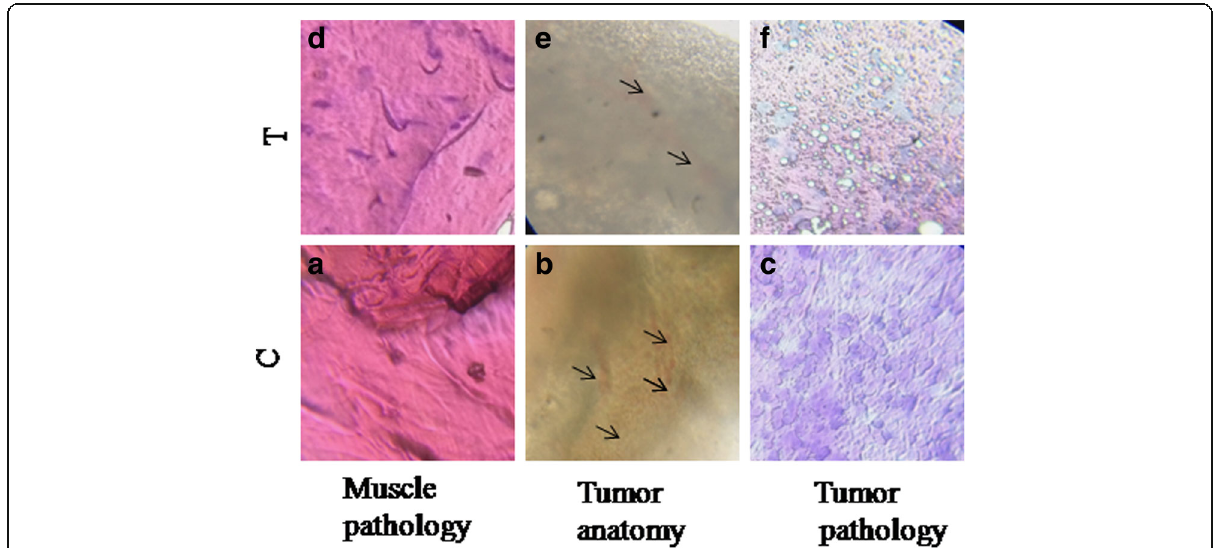
Fig. 8 In vivo analysis of antitumor activity. a , b , c Histopathological analysis of muscle and tumor of tumor induced zebrafish. d , e , f Histopathological analysis of muscle and tumors from GAE treated tumor induced zebrafish. C-control,